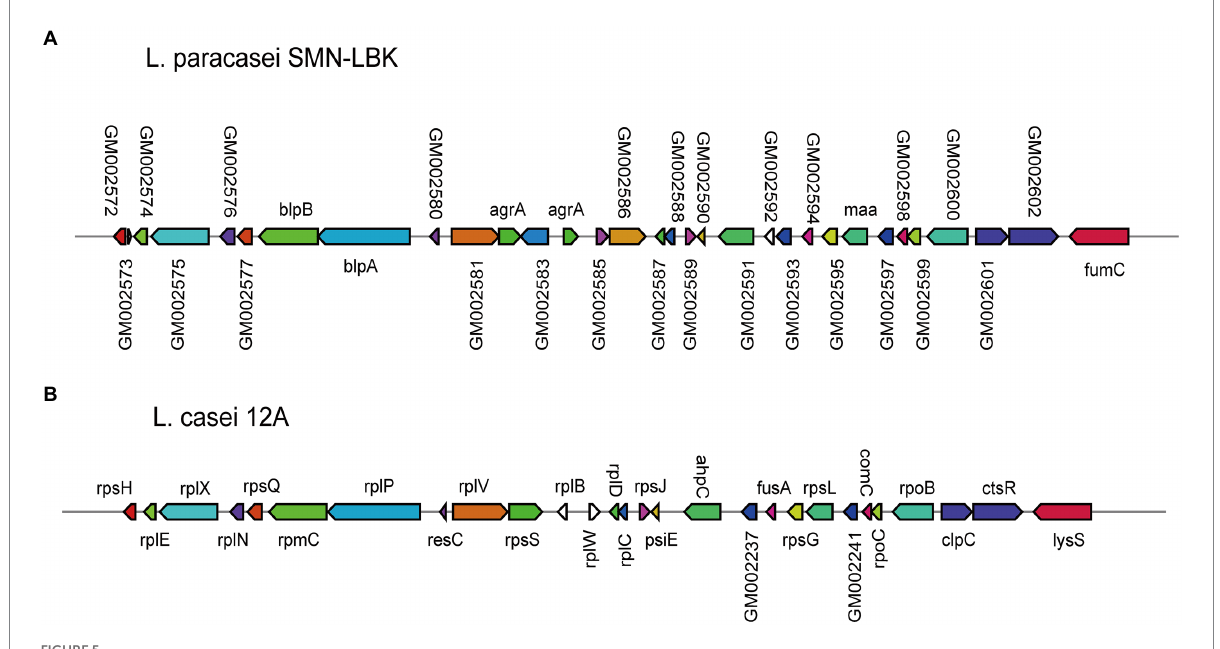
FIGURE 5 Comparative analysis of bacteriocin-producing loci for L. paracasei SMN-LBK and L. casei 12A. (A) Represents the bacteriocin produced by L. paracasei SMN-LBK. (B) Represents the bacteriocin produced by L. casei 12A. Different colors and sizes represent different